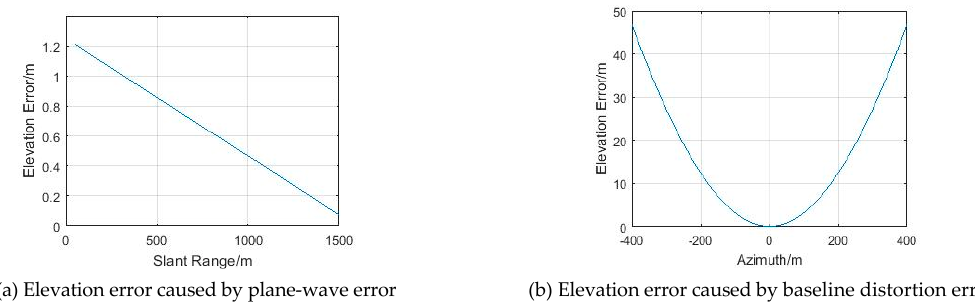
Figure 4. The key problems in GB-InSAR DEM generation.